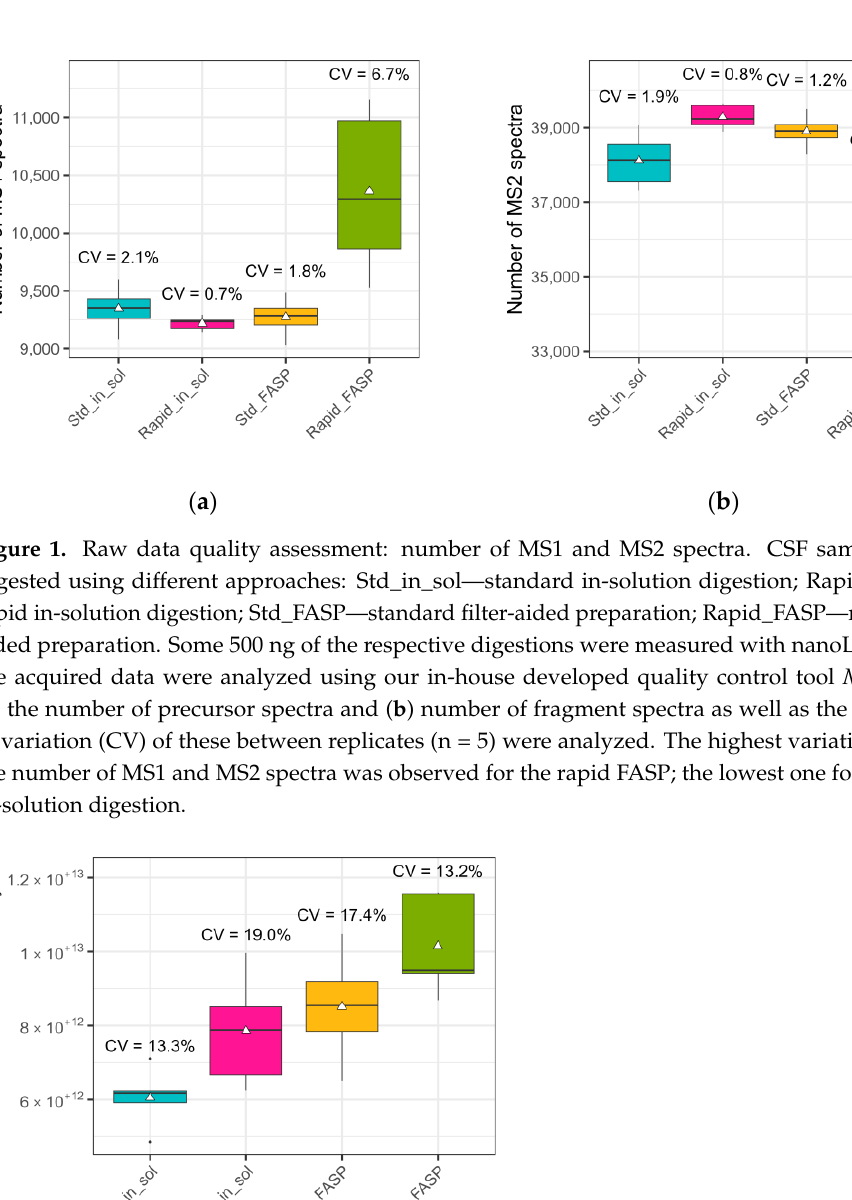
Figure 2. Raw data quality assessment: MS1 accumulated intensity. Accumulated TICs and the coefficient of variation (CV) for these between replicates (n = 5) were analyzed. The variation between the replicates did not exceed 20%, regardless of the sample preparation protocol. The highest CV was found for rapid in-solution digestion (19%); the lowest for standard in-solution digestion (13.3%) and rapid FASP (13.2%).